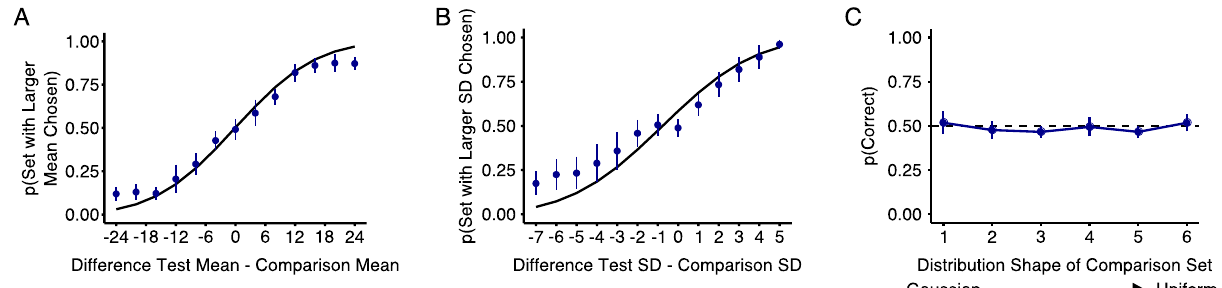
Figure 5. Explicit discrimination of color ensembles differing in ( A ) mean, ( B ) standard deviation, or ( C ) probability distribution shape. In each task, observers have to choose the set that was more similar to the (distractor) ensemble in the preceding visual search trial. In ( A ) and ( B ) the fitted curve corresponds to a cumulative Gaussian using the averaged mean and SD across observers. Data was averaged across all bootstrapped samples and all 18 observers. In panel ( C ) raw data was averaged across all 18 observers. Error bars show 95% confidence